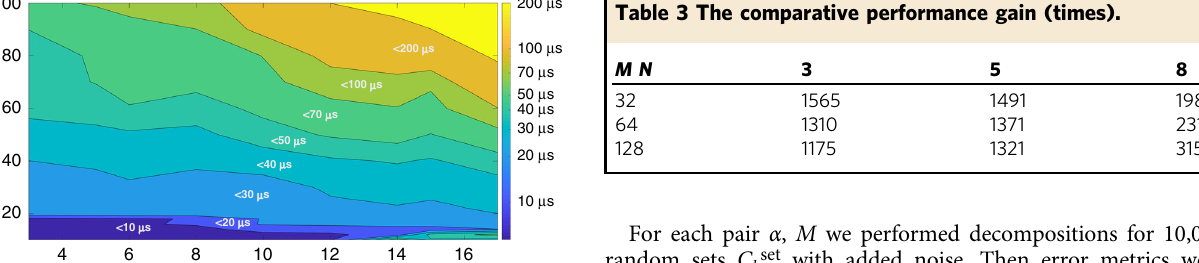
Table 3 The comparative performance gain (times).